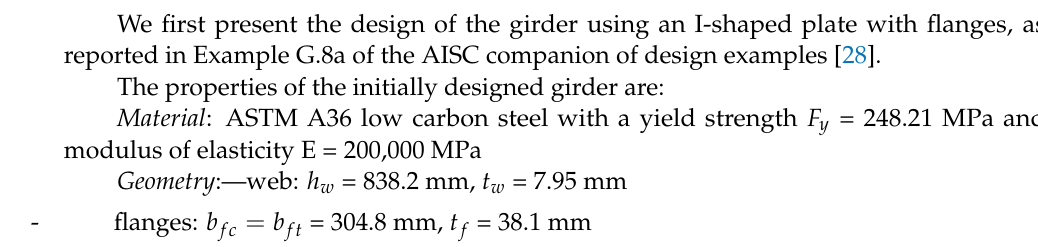
Figure 12. Girder and loading of Application